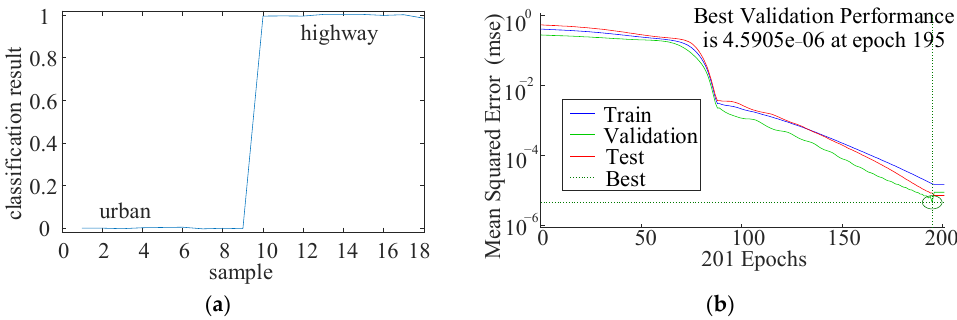
Figure 4. Classification results and verification. ( a ) Classification result; ( b ) Convergence of the BP network.